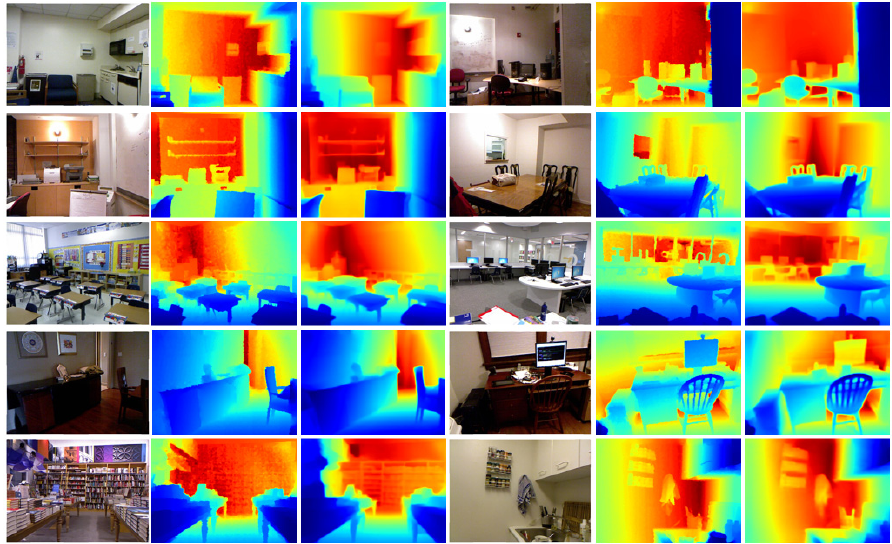
Figure A1. Example outcomes for the proposed method on NYU-Depth-V2. Columns from left to right: original RGB images, ground truth depth maps, and proposed model predicted depth maps. Colors indicate depth; red is far, and blue is close.